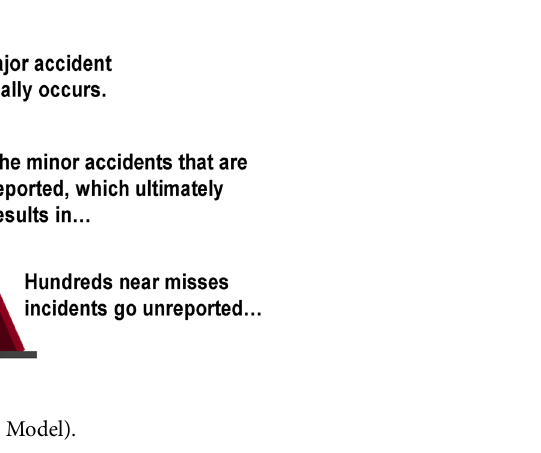
Figure 2. Heinrich Law (300-29-1